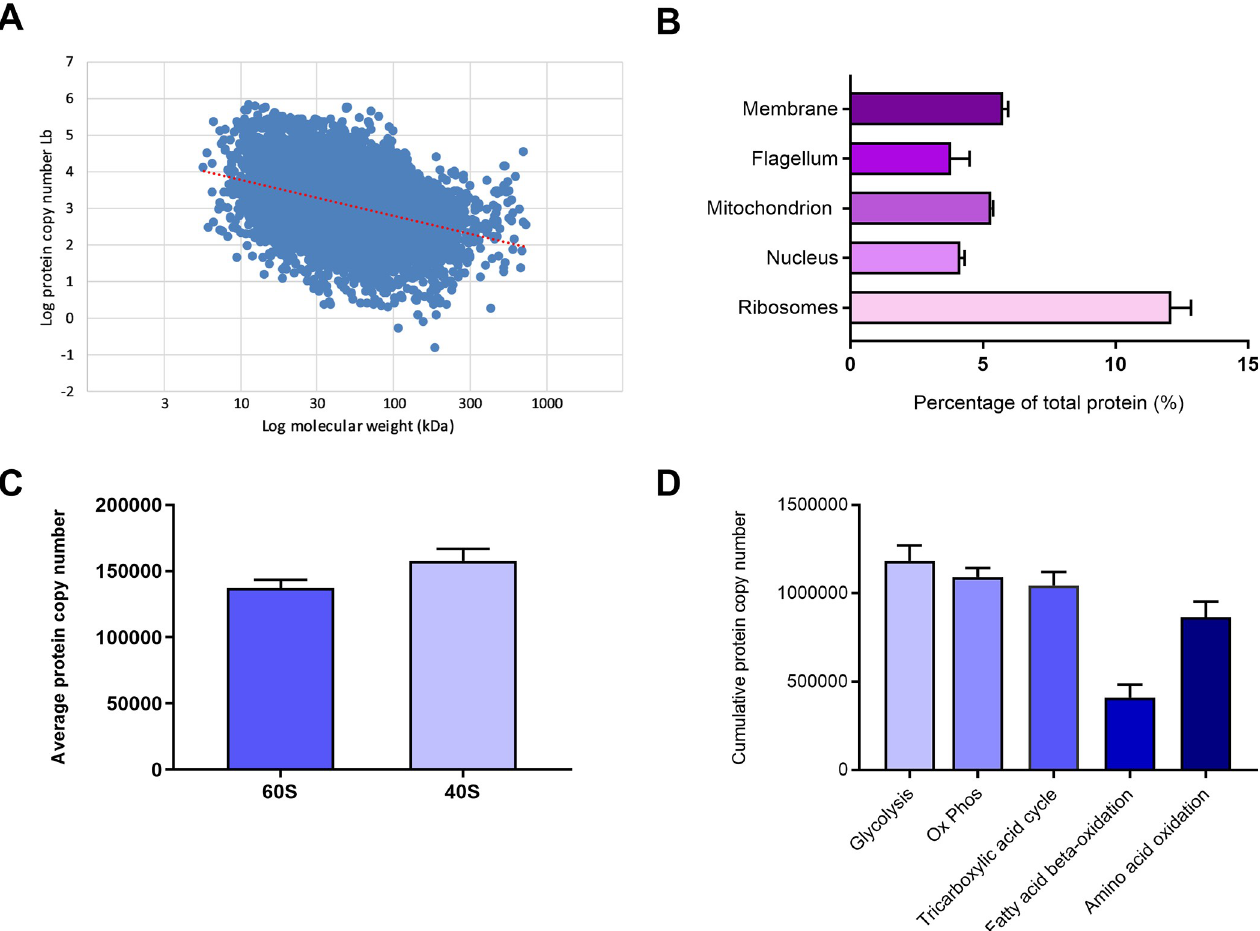
Fig 2. Quantitative analysis of the proteomes of Leishmania ( Viannia ) species. (A) Correlation between protein copy numbers and molecular weight, R 2 = 0.129. Every blue dot represents a single protein. Red dotted line = tendency line. (B) Protein abundance of basic components of promastigotes architecture based on the current gene ontology annotations of cellular component. The values represent the mean of percent of total cellular protein content ± SD (n = 14). (C) Abundance of ribosomal proteins of the large and small subunits. The values represent the mean of protein copy numbers ± SD (n = 14). (D) Cumulative abundance of proteins involved in the major energy metabolic processes. Bars show the total sum of the number of copies of proteins involved in each metabolic pathway ± SD (n = 14).